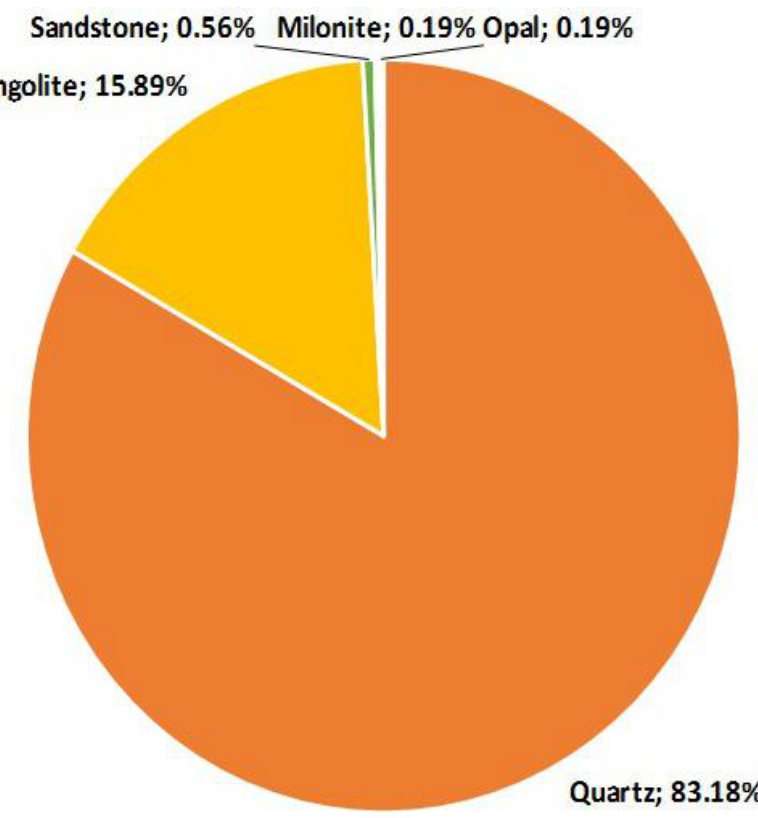
Figure 4.Graph showing the lithologies identified within the archaeological record at the Ciota Ciara cave, S.U. 13 and